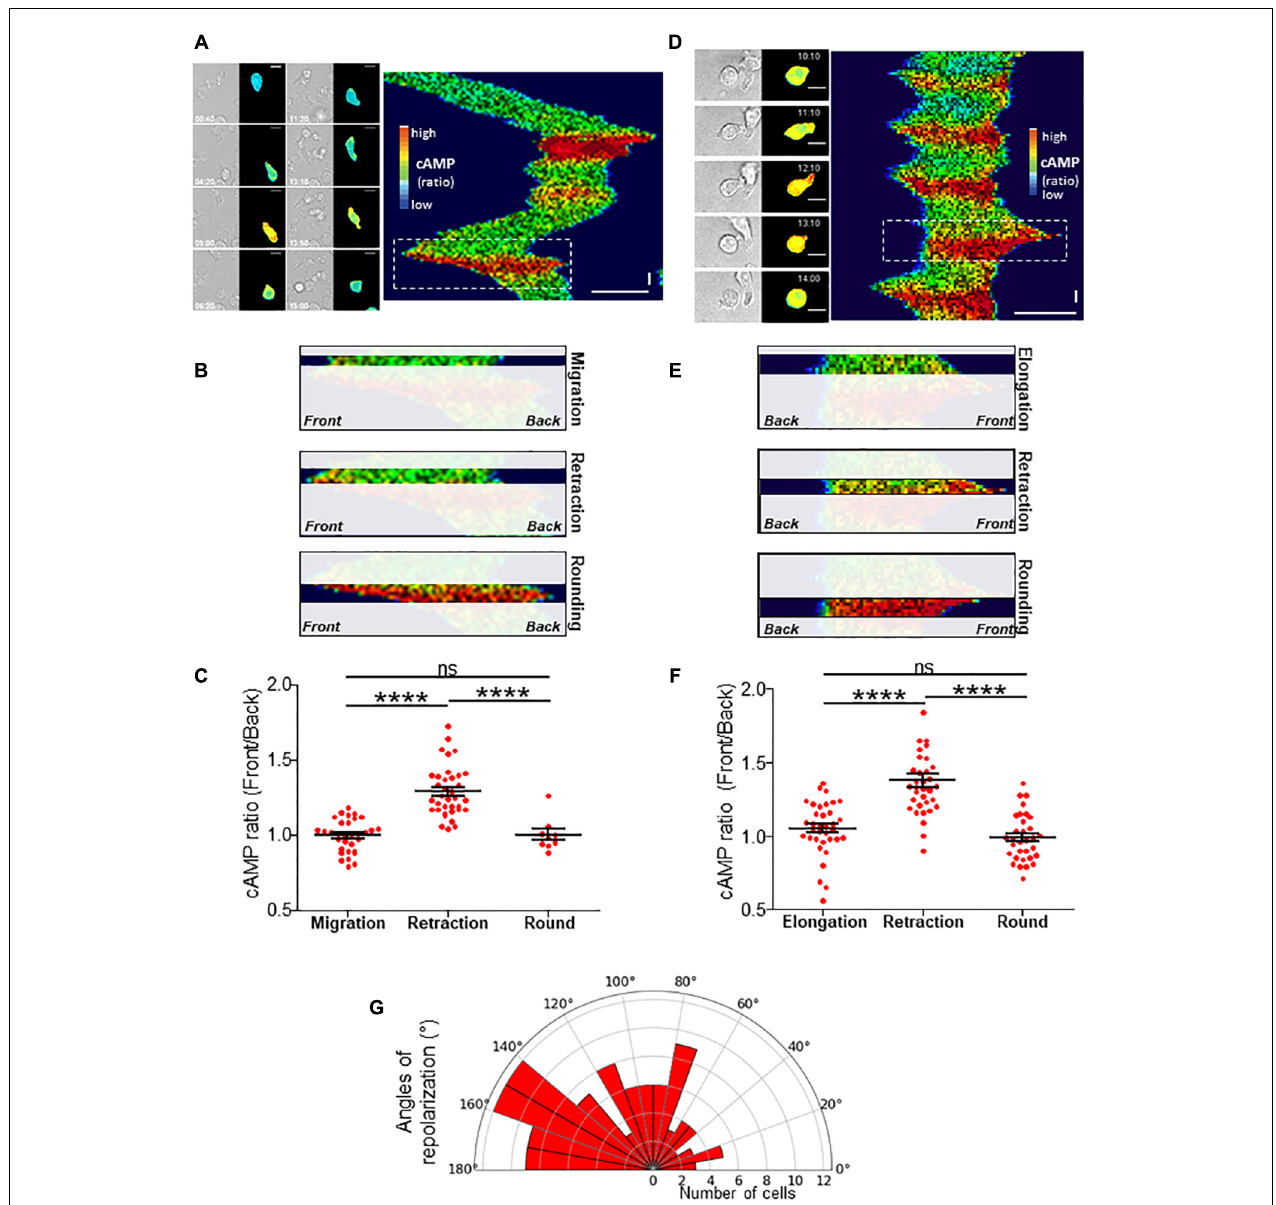
FIGURE 3 | cAMP variations upon migration. (A) Example of a TEpacVV-transfected T cell migrating on a CXCL12/VCAM-1-coated coverslip. The corresponding kymograph was established along the antero-posterior axis of the cell. The x axis corresponds to the average cAMP level along the cell while the y axis corresponds to time. cAMP levels were coded in false colors. The complete series of images is shown in Supplementary Movie 5 . Horizontal scale bar = 10 µ m, vertical scale bar = 1 min. (B) Zoom of the zone corresponding to the white rectangle in the kymograph presented in (A) illustrating that the increase of cAMP starts from the front before invading the whole cell. (C) Ratios of cAMP level from the front to the back of the cell were measured by drawing scanlines along antero-posterior axis in migrating cells, cells retracting their lamellipodium or after they rounded up. Values correspond to the mean ± SE of 32 events (migration), 36 events (retraction), 8 values (round cells after retraction) from 11 different cells. Statistical analysis was performed through a one way ANOVA test with a Tukey post-test. **** p < 0.0001. (D) Example of cAMP variations measured in a TEpacVV-transfected T cell displaying elongation/retraction cycles on a CXCL12/VCAM-1-coated coverslip. During recording, the cell presents 5 such cycles as displayed on the kymograph. The complete series of images is displayed in Supplementary Movie 6 . Horizontal scale bar = 10 µ m, vertical scale bar = 1 min. (E) Zoom of the zone corresponding to the white rectangle in the kymograph presented in (D) illustrating that the increase of cAMP starts at the front before invading the whole cell. (F) Ratios of front to back cAMP levels measured in cells displaying elongation/retraction cycles. Values correspond to the mean ± SE of 35 values (elongation), 35 values (lamellipodium retraction) and 32 values (round cells after retraction) from 9 different cells. Statistical analysis was performed through a one way ANOVA test with a Tukey post-test. **** p < 0.0001. (G) Polar distribution of repolarization angles. Values correspond to the angle formed between polarization axes observed between two consecutive lamellipodia separated by cAMP-induced lamellipodium retraction. Width of sectors = 10 ◦ . Values correspond to 111 measurements performed on 37 different